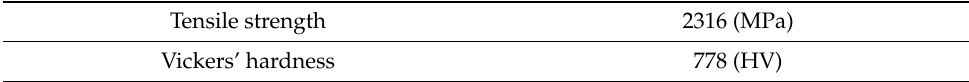
Table 1. Static mechanical properties of the